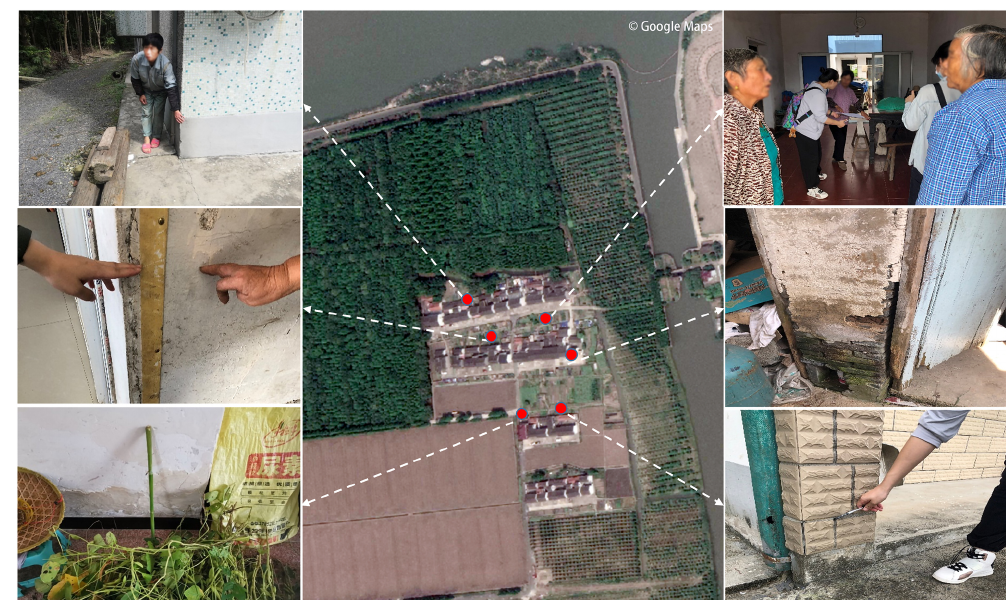
Figure 3. Field investigation of flood inundation after the